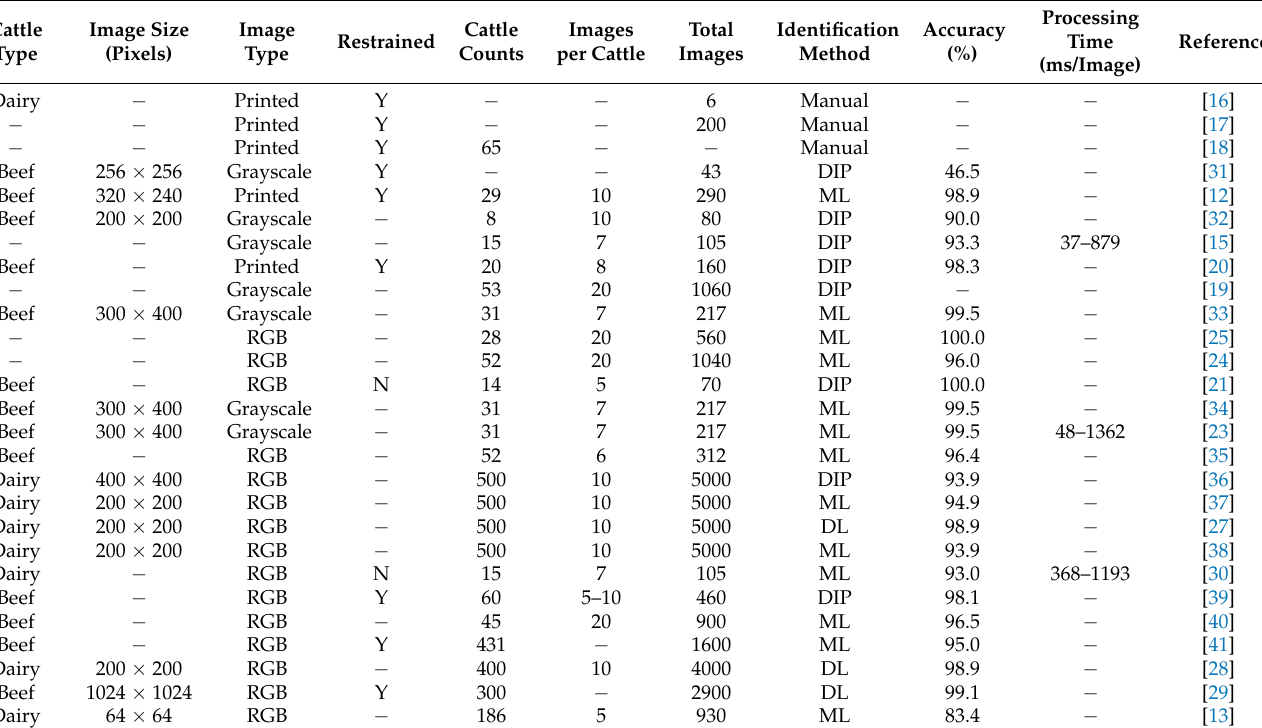
Table 1. Reference summary from previous cattle muzzle identification